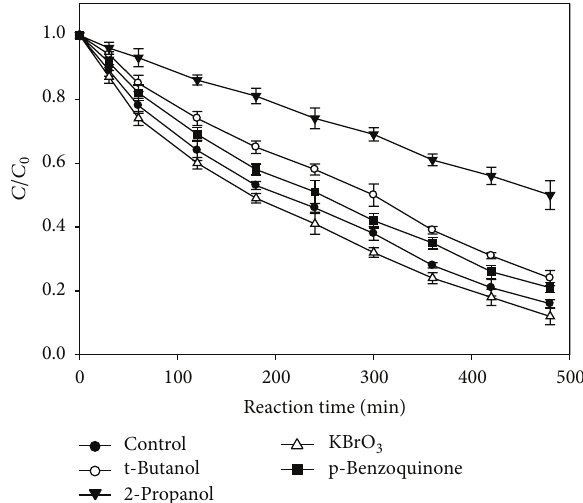
Figure 10: Effect of different scavengers on photocatalytic decom- position PFOA. The concentration of t-butanol, 2-propanol, KBrO 3 , p-benzoquinone in reaction solution were